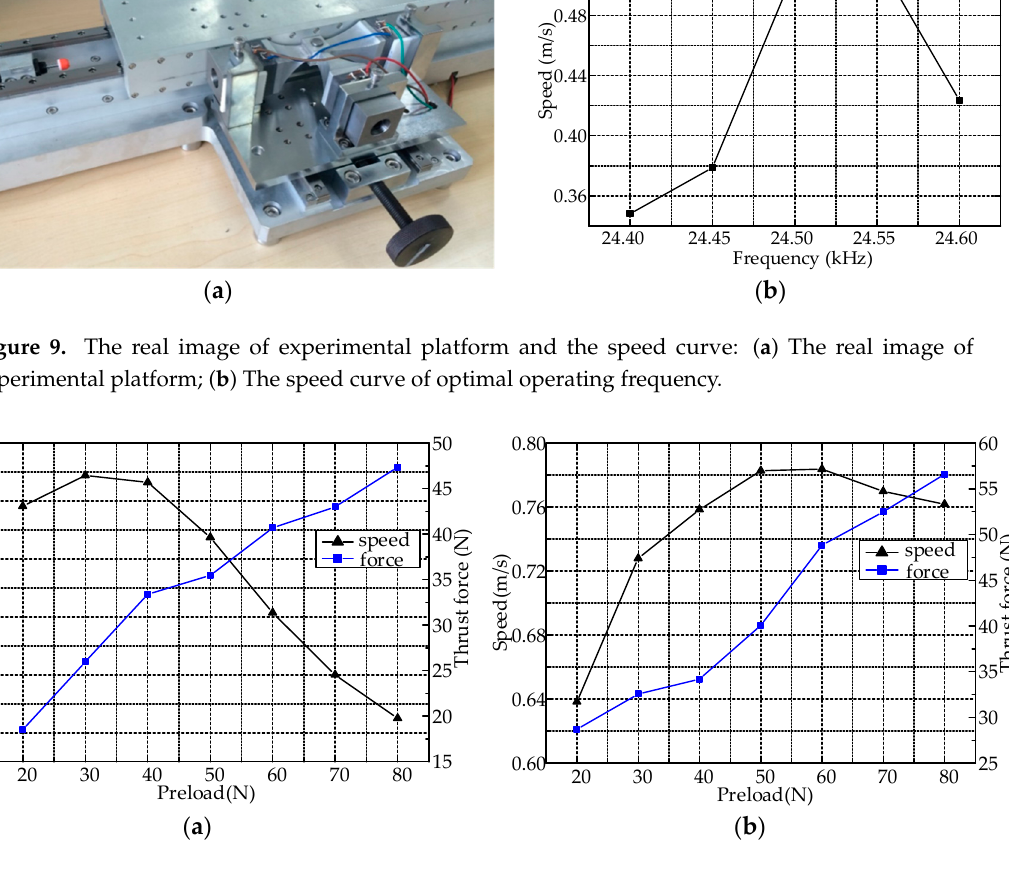
Figure 10. The mechanical output performance of the prototype: ( a ) Plot of the no-load speed and force under the voltage of 150 V rms ; ( b ) Plot of a 15 kg inertia load speed and force under the voltage of 150 V rms .